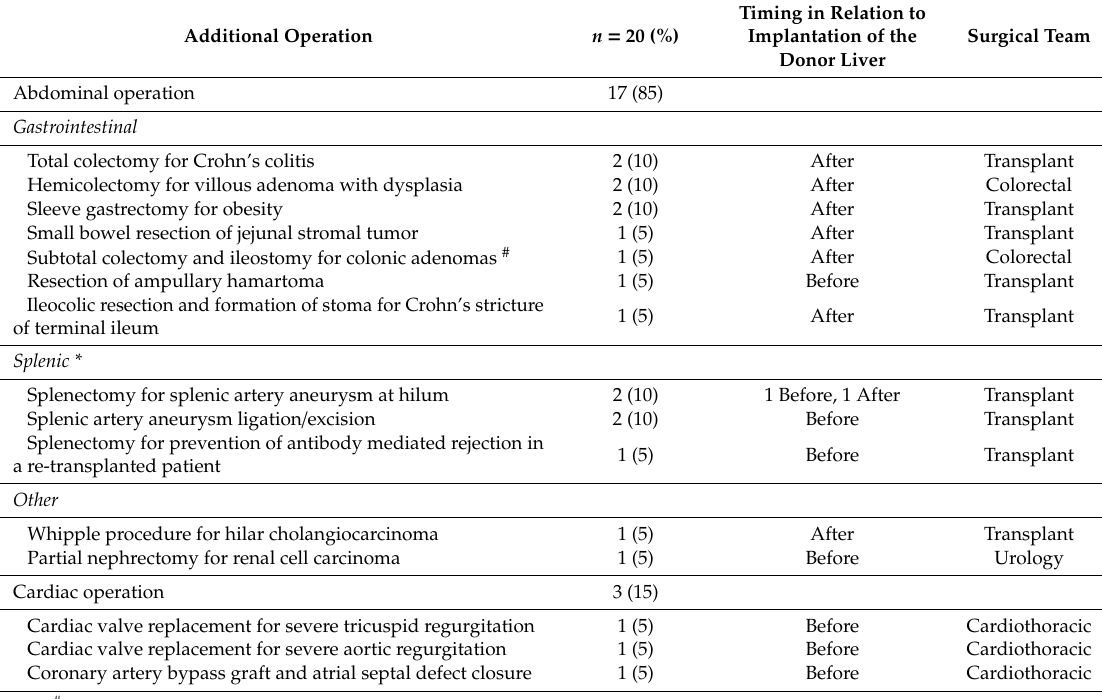
Table 2. Additional operation characteristics.